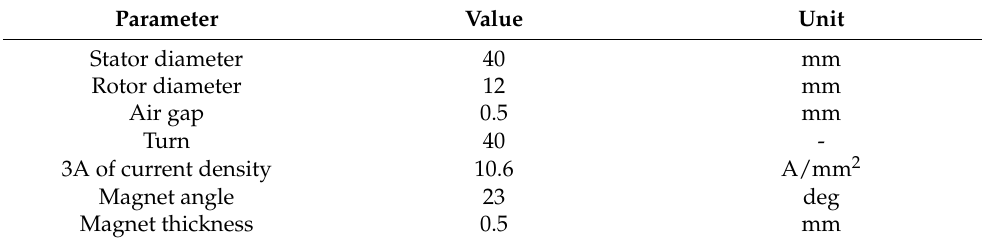
Figure 12. STMB and HSTMB’s magnetic flux line: ( a ) STMB magnetic flux line and ( b ) HSTMB magnetic flux line.